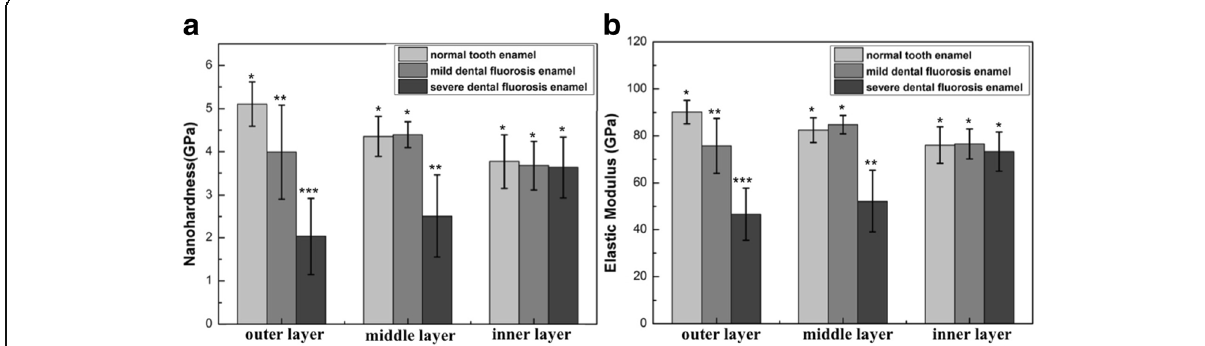
Fig. 3 Nanomechanical properties of the enamel layers of the normal tooth, mild dental fluorosis, and severe dental fluorosis. a Nanohardness. b Elastic modulus. Identical symbols denote no significant difference in nanohardnesses and elastic moduli among the corresponding layers of the normal tooth enamel, mild dental fluorosis enamel, and severe dental fluorosis enamel